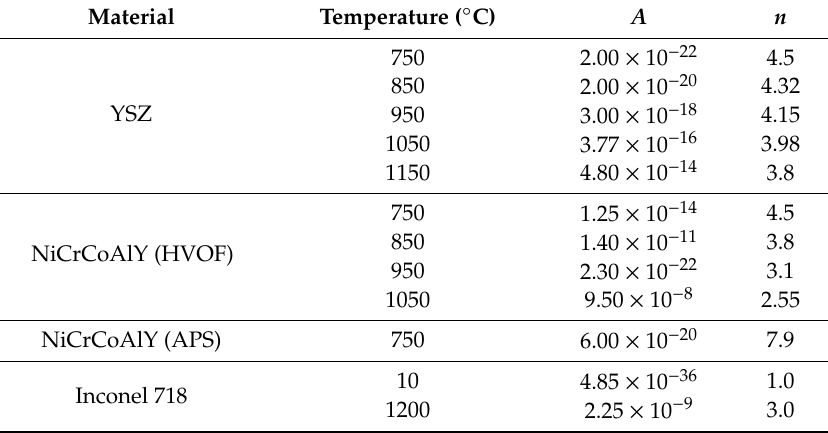
Table 1. Temperature-dependent creep constants used in the FE model